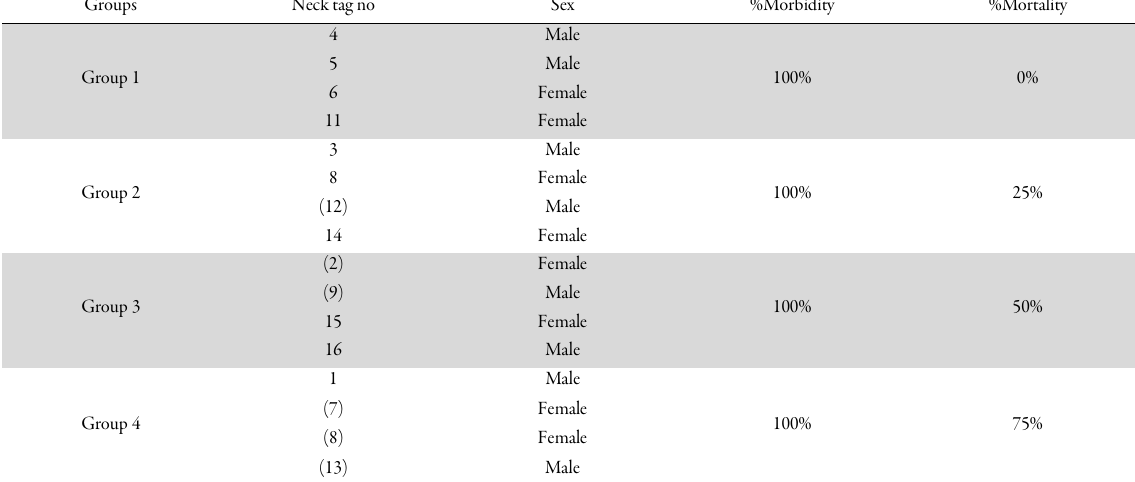
Table 2. Morbidity and mortality pattern in different treatment combinations